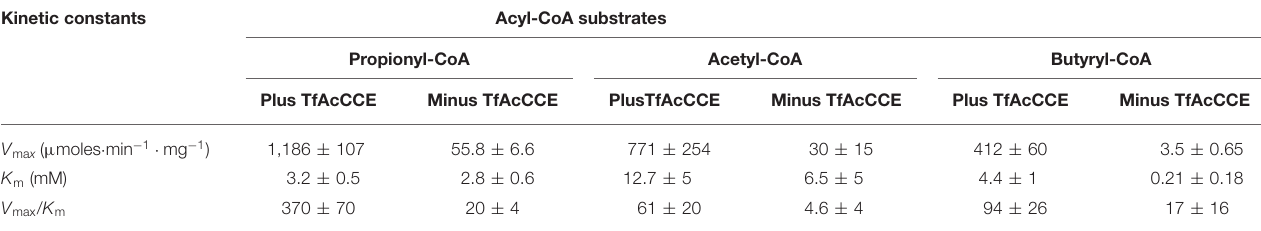
TABLE 1 | The effect of inclusion of the TfAcCCE subunit on the carboxylation of propionyl-CoA, acetyl-CoA and butyryl-CoA substrates catalyzed by TfAcCCase. Kinetic